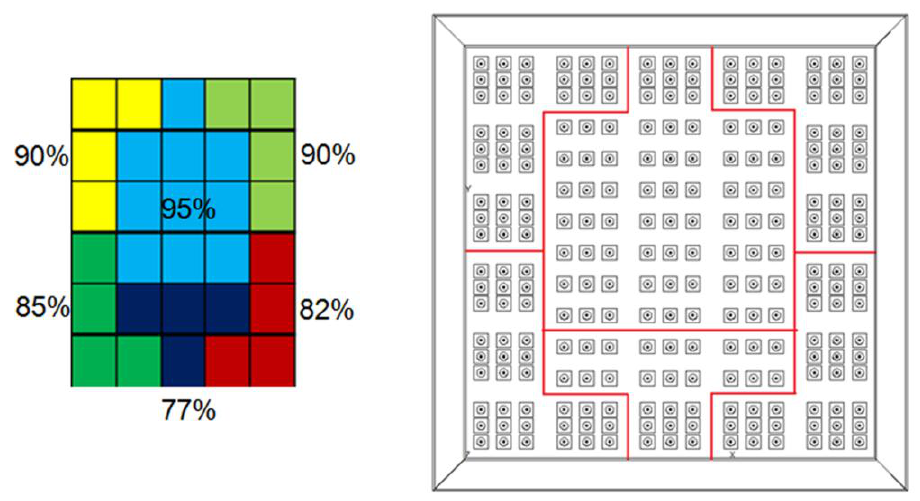
Figure 23. LED power distribution: type 1.